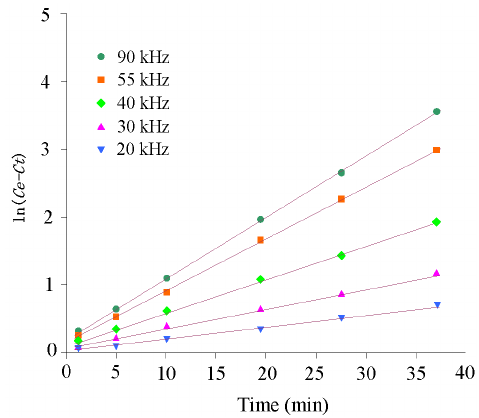
Figure 6. The relationship of ln ( C e − C t ) against extraction time ( t ) under different ultrasonic frequencies. Table 2. Parameters of kinetic model of glycyrrhizic acid from Glycyrrhiza uralensis with different ultrasonic frequencies.